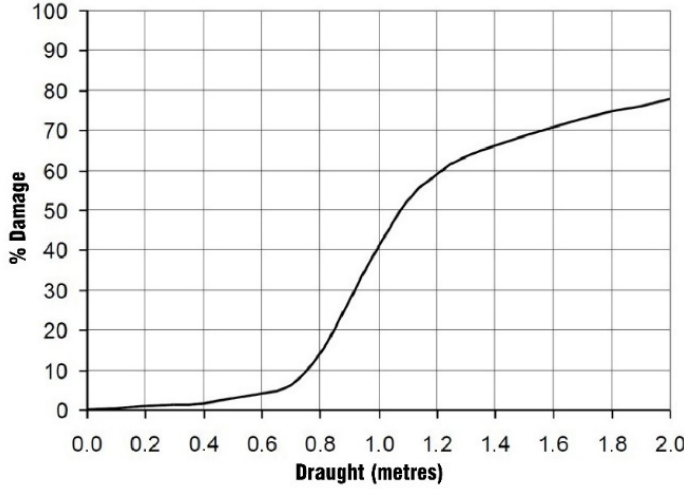
Figure 7. Evolution of the percentage of damage depending on the maximum depth for generic use. Own elaboration based on [11] .